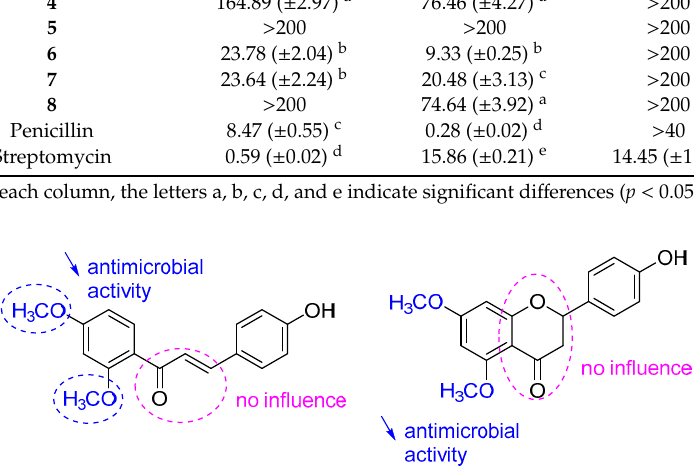
Figure 5. Structure/activity relationships established for antibacterial effect against M. luteus .